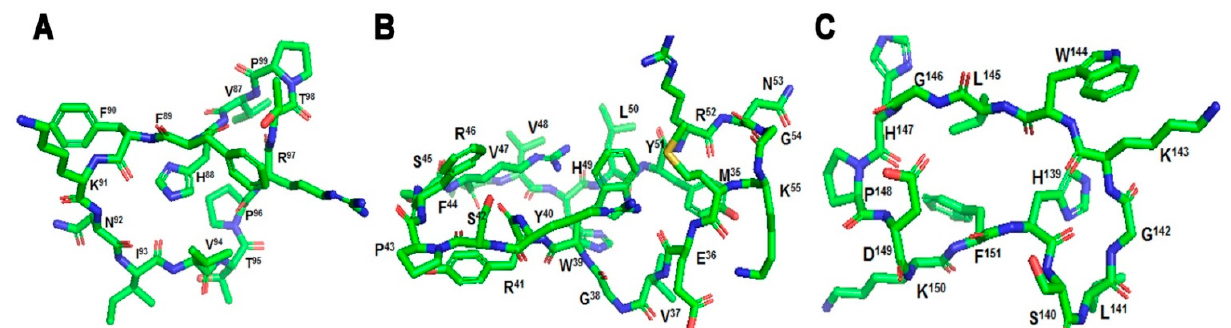
Figure 5. ( A ) cyclic-MBP 87–99 (VHFFKNIVTPRTP), ( B ) cyclic-MOG 35–55 (MEVGWYRSPFSRVVHLYRNGK), ( C ) cyclic-PLP 139–151 (HSLGKWLGHPDKF).